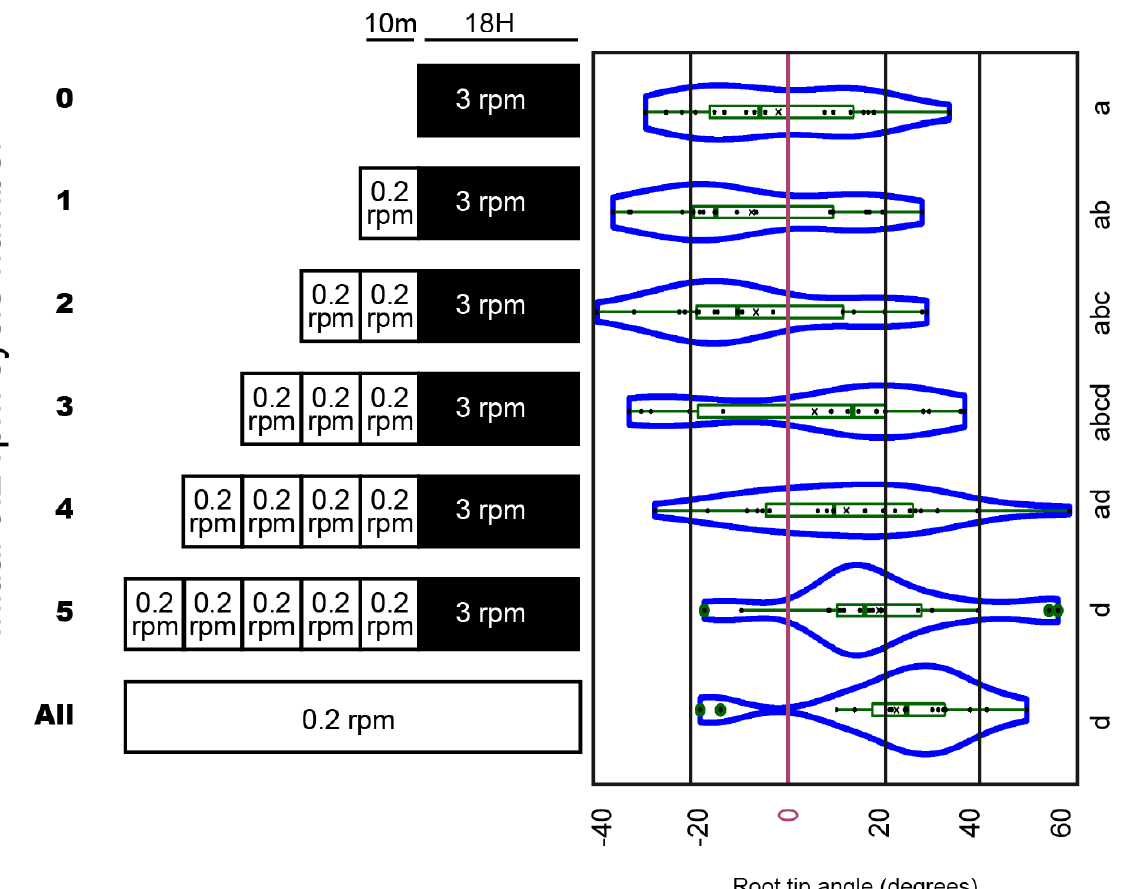
Figure 4. Several rounds of inductive clinorotation are needed for maximal root tip curvature re- sponse: 5-day-old wild type Arabidopsis thaliana seedlings (Col accession) were subjected to 0, 1, 2, 3, 4, or 5 rounds of inductive 0.2 RPM clinorotation in darkness before being exposed to 18 h non-inductive clinorotation at 3 RPM. Root tip angles were measured at the end of each experiment and plotted over the number of inductive clinorotation rounds. The results are represented in the form of a violin chart. The box plots within each violin indicate median (horizontal bar) and mean values (X), along with the quartiles (rectangular boxes) and standard deviations (whiskers) of the distributions. One-way ANOVA analysis was performed. Different letters identify significantly different responses (Tukey’s HSD test, p < 0.05). This experiment was repeated twice, with similar results.